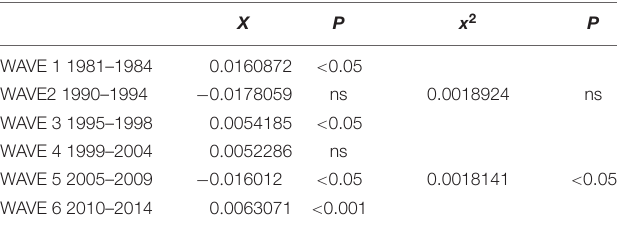
TABLE 4 | Estimates and significances of the linear mixed model of number of children on basis a Poisson error structure regressing on political orientation, age, sex, education (lowest education level 1 as reference), scales of income, and frequency of attendance of religious services, with country as random factor, separately for single waves of the